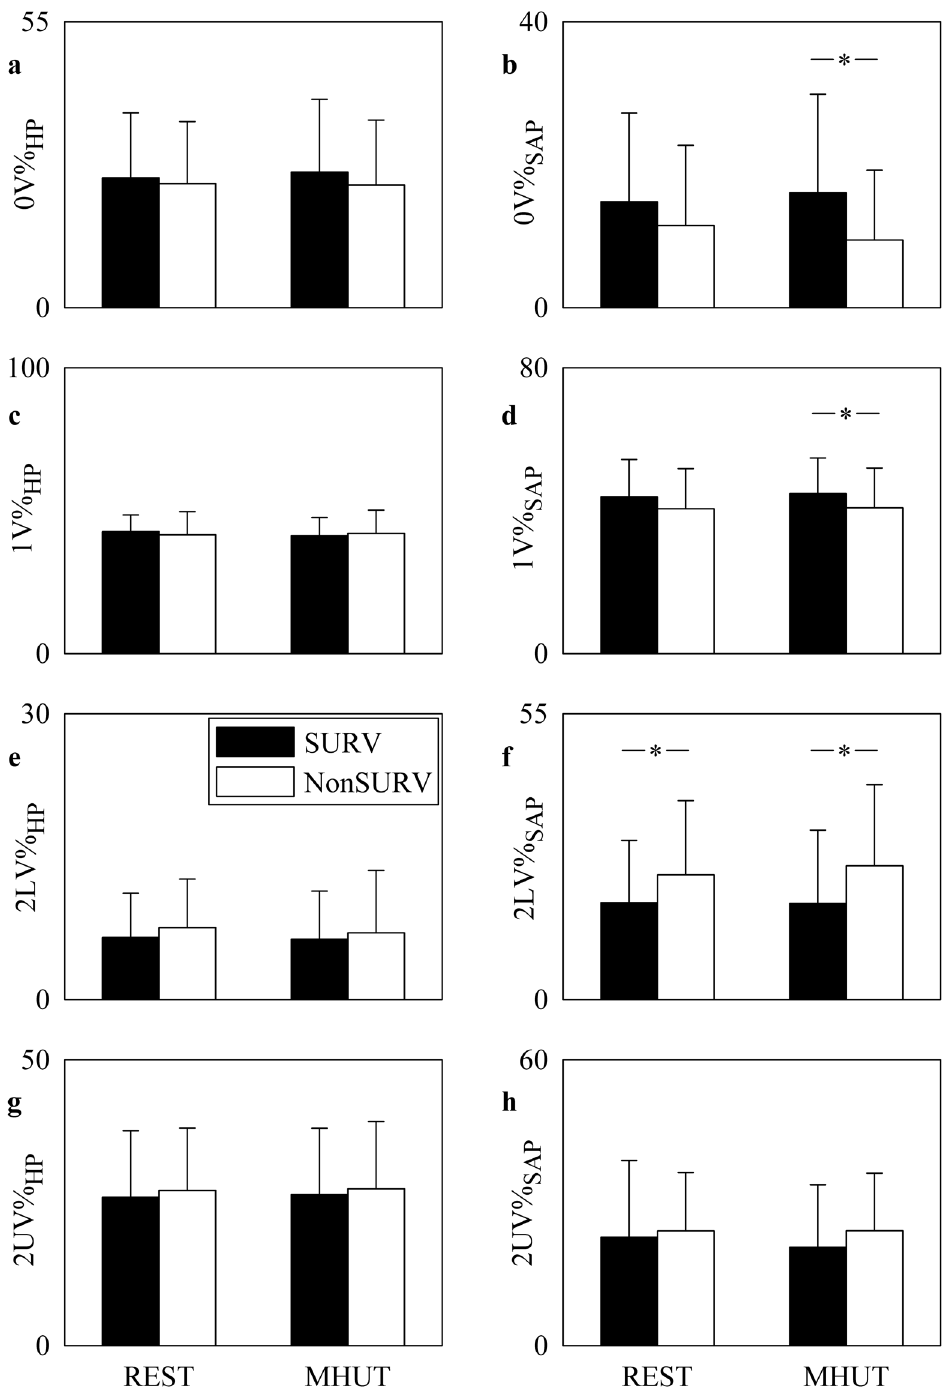
Figure 3. The bar graphs show 0 V% ( a , b ), 1 V% ( c , d ), 2LV% ( e , f ) and 2UV% ( g , h ) computed over HP ( a , c , e , g ) and SAP ( b , d , f , h ) series as a function of the experimental condition (i.e. REST and MHUT) in SURVs (dark bar) and NonSURVs (white bar). Data are reported as mean plus standard deviation. The symbol * indicates p <